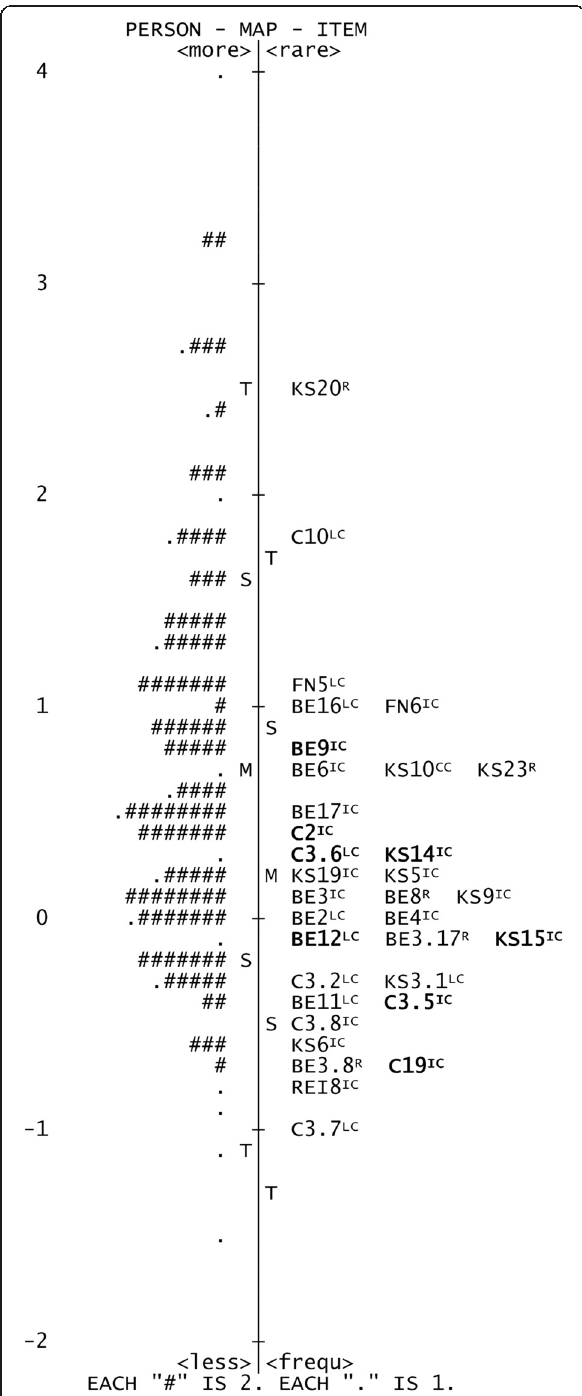
Fig. 6 Person-item variable map for